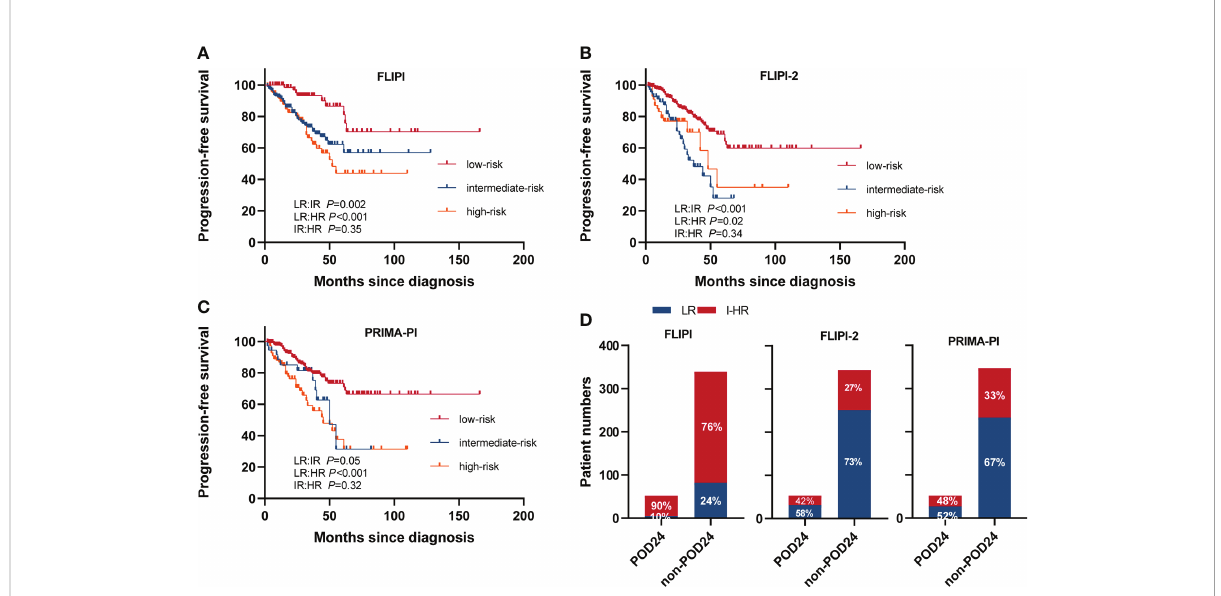
FIGURE 6 PFS in different scoring systems. (A) FLIPI, (B) FLIPI2, and (C) PRIMA-PI. (D) Accuracy of the three risk models to predict POD24 status. LR, low risk; IR, intermediate risk; HR, high